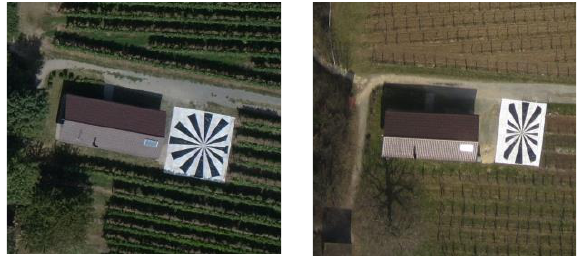
Figure 4: Image sections depicting the Siemen star for Ricoh flown August, 23 rd (left) and Canon flown March, 23 rd (right) For resolution measurements a Siemens star was signalized, additionally. Exemplary image sections from the performed flights are depicted in Figure 4. These examples additionally show the considerable differences for the state of the vegetation for the performed flights. Vegetation is fully developed for the Ricoh flight on the left, which was captured at August, 23, 2013. In contrast, no leaves are available for the Canon flight on the right, which was captured at March, 23, 2013.